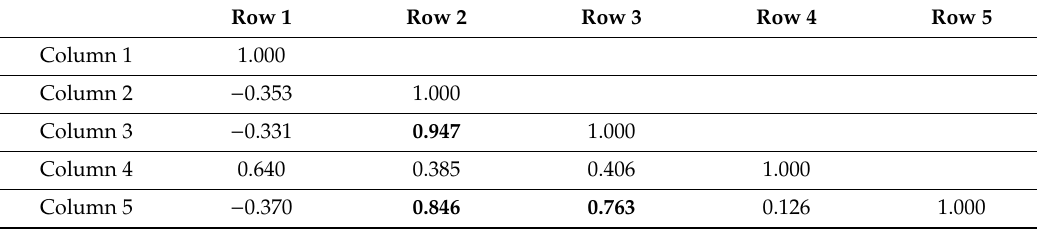
Table 5. Correlation analysis between elements (five items).